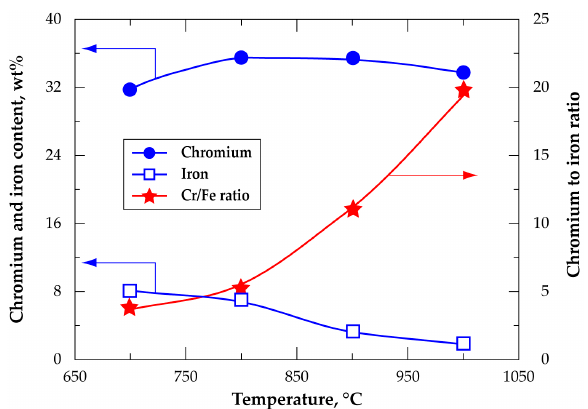
Figure 17. Evolution of chromium and iron content and chromium to iron ratio versus temperature during treatment of HGChC in a Cl 2 +air gaseous mixture.